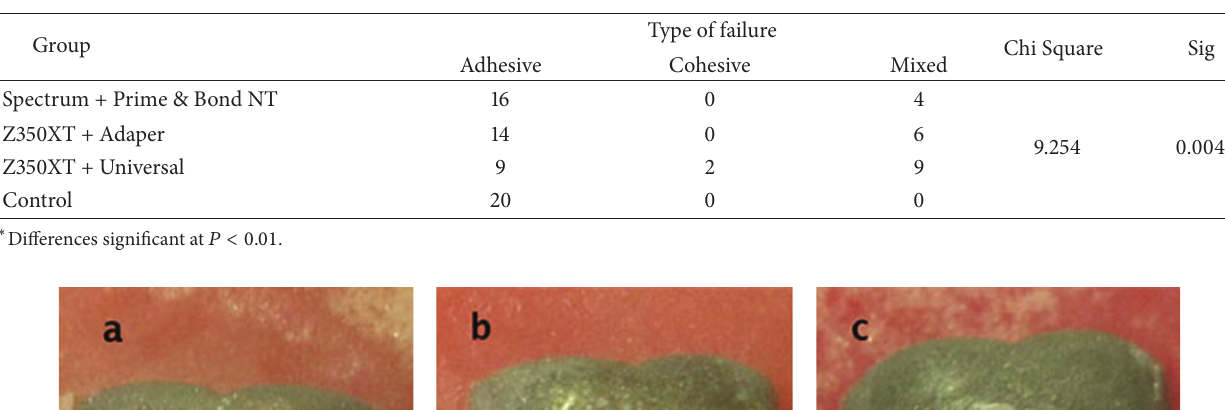
Table 3: Types of failure observed.